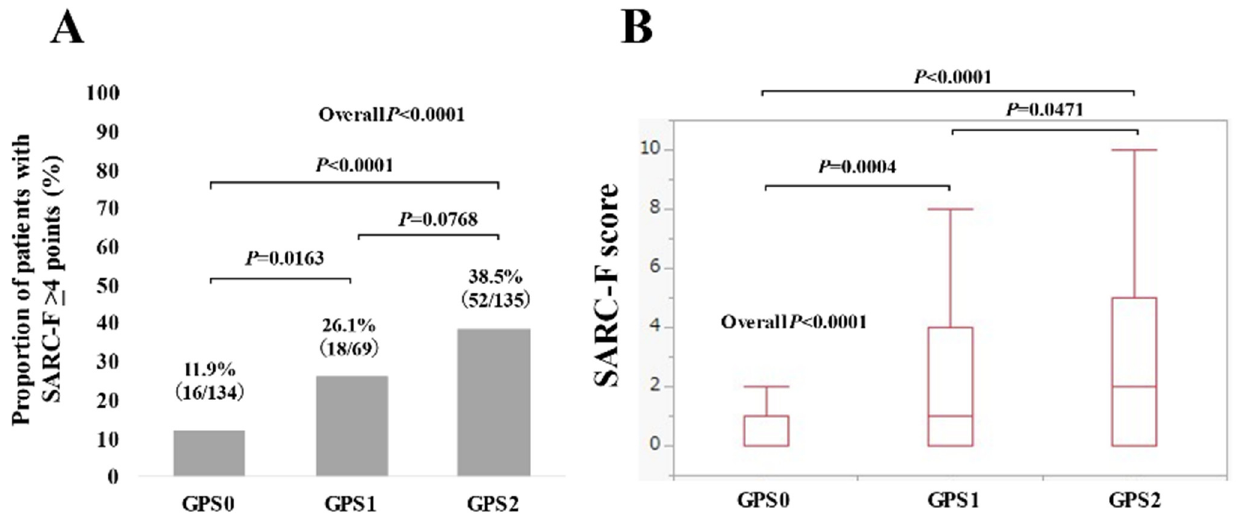
Figure 6. ( A ) The proportion of patients with SARC-F ≥ 4 points according to Glasgow prognostic scores (GPSs). ( B ) SARC-F scores according to GPSs.